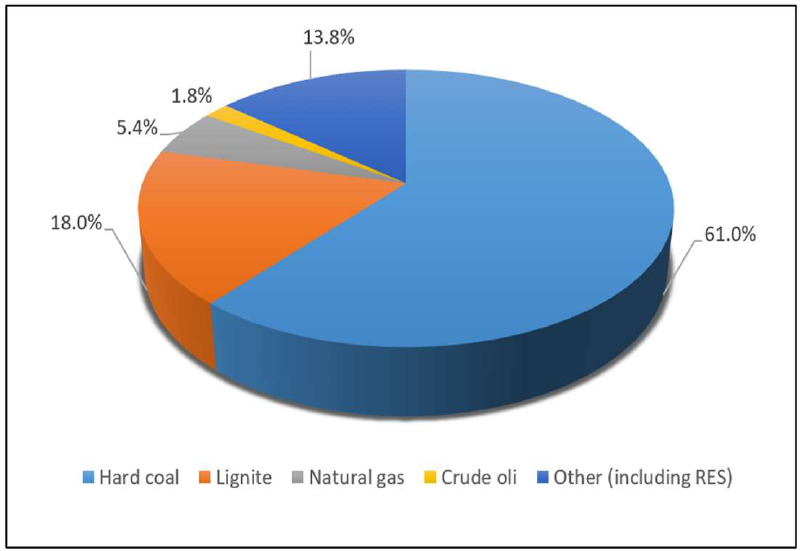
Figure 1. The percentage share of energy carriers in energy production in Poland. It is obviously important to strengthen Poland’s energy security in the area of gas and of these raw